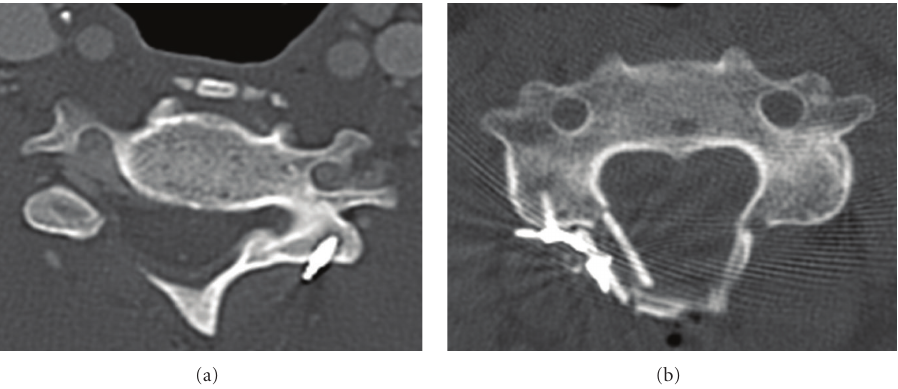
Figure 9: Axial CT scans of patients following expansive open-door laminoplasty. The laminar opening has been maintained with suture anchors (a) and miniplate fixation